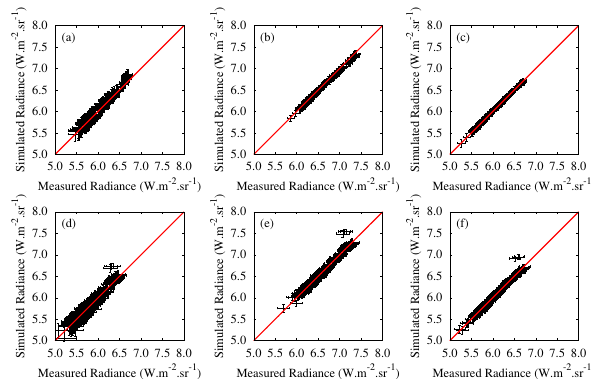
Fig. 2. Scatterplots of comparisons between the radiances measured and the radiances simulated using the optimal retrieved parame- ters, along the 16 May 2007 leg. (a–c) Using CLIMAT-AV mea- surements. (d–f) Using IIR measurements. (a, d) , (b, e) , and (e, f) correspond to the channels centered at 8.65µm (a) , 10.60µm (b) , and 12.05µm,